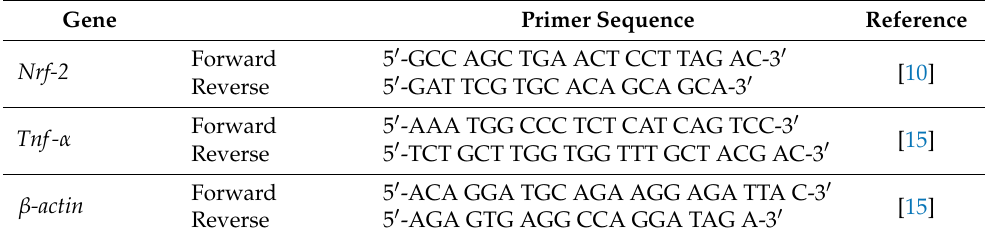
Table 1. The primer sequences for pro-inflammatory cytokine gene. Gene Primer Sequence